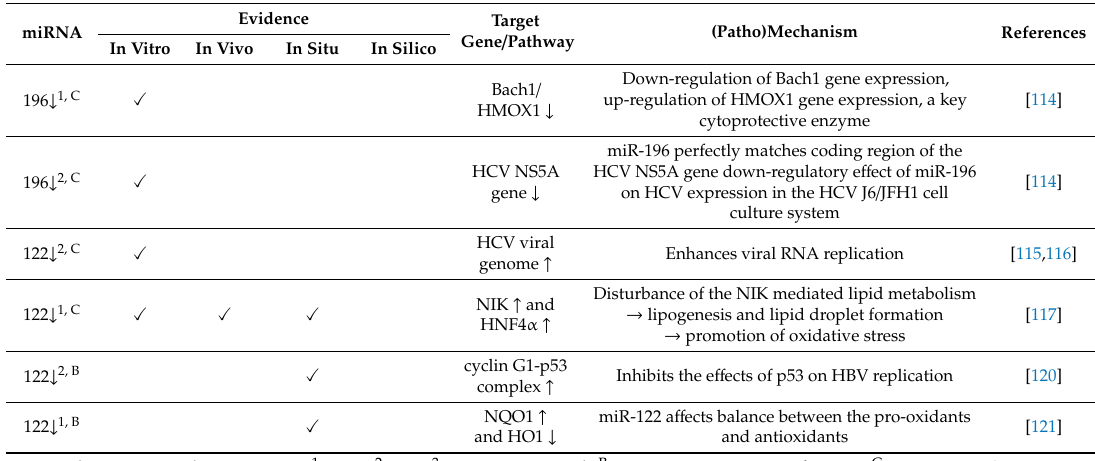
Table 4. Deregulated miRNAs and relation to OS in viral